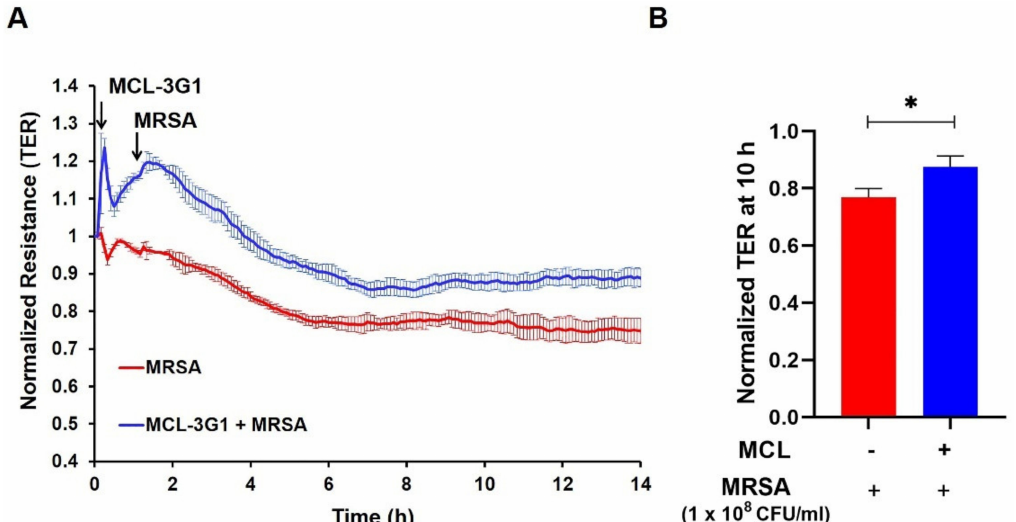
Figure 5. HK-MRSA-induced lung endothelial barrier dysfunction is attenuated by a monoclonal blocking antibody against gVPLA 2 (MCL-3G1). HPAEC were pre-treated with MCL-3G1 (25 µ g/mL, 1 h) and then challenged with HK-MRSA (1 × 10 8 CFU/mL). ( A ): TER values were recorded over time. ( B ): Normalized TER values at the 10-h time point. * p < 0.05. n =